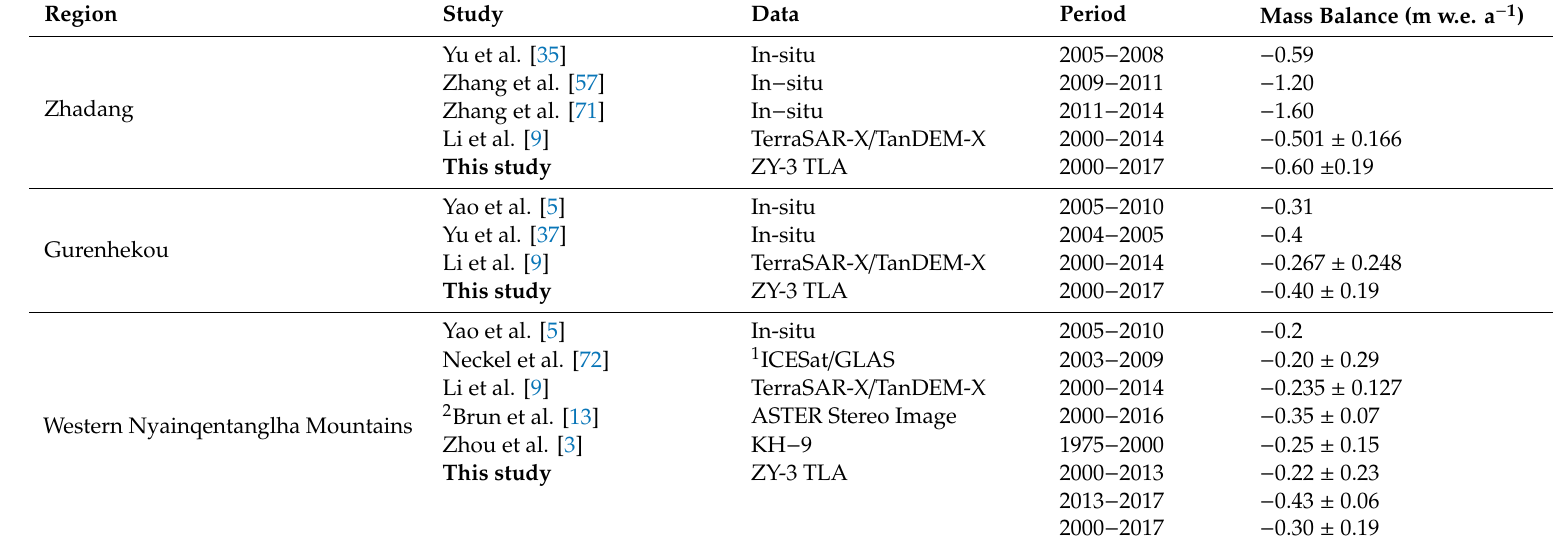
Table 8. Comparison of our geodetic glacier mass balance retrievals with previous studies in the WNM.